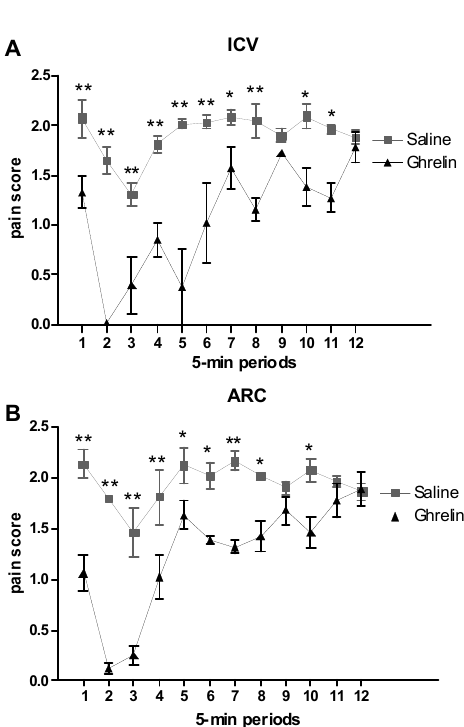
Figure 2 . ( A ) Time courses of the pain scores recorded during the formalin test in animals treated with Saline-ICV or Ghrelin-ICV. ( B ) Time courses of the pain scores recorded during the formalin test in animals treated with Saline-ARC or Ghrelin-ARC. Data are mean ± SEM. ** p < 0.001 and * p < 0.05 vs. other group, same time